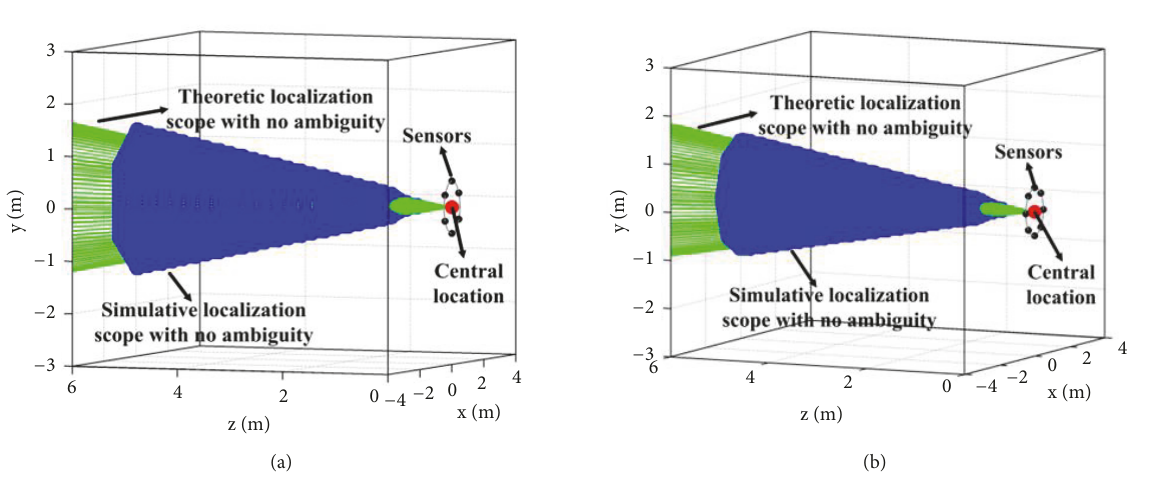
Figure 3: Comparison of unambiguous parameter estimation zones under three-dimensional situation. (a) 𝑀 = 6, 𝑙 = 2 . (b) 𝑀 = 8, 𝑙 = 3